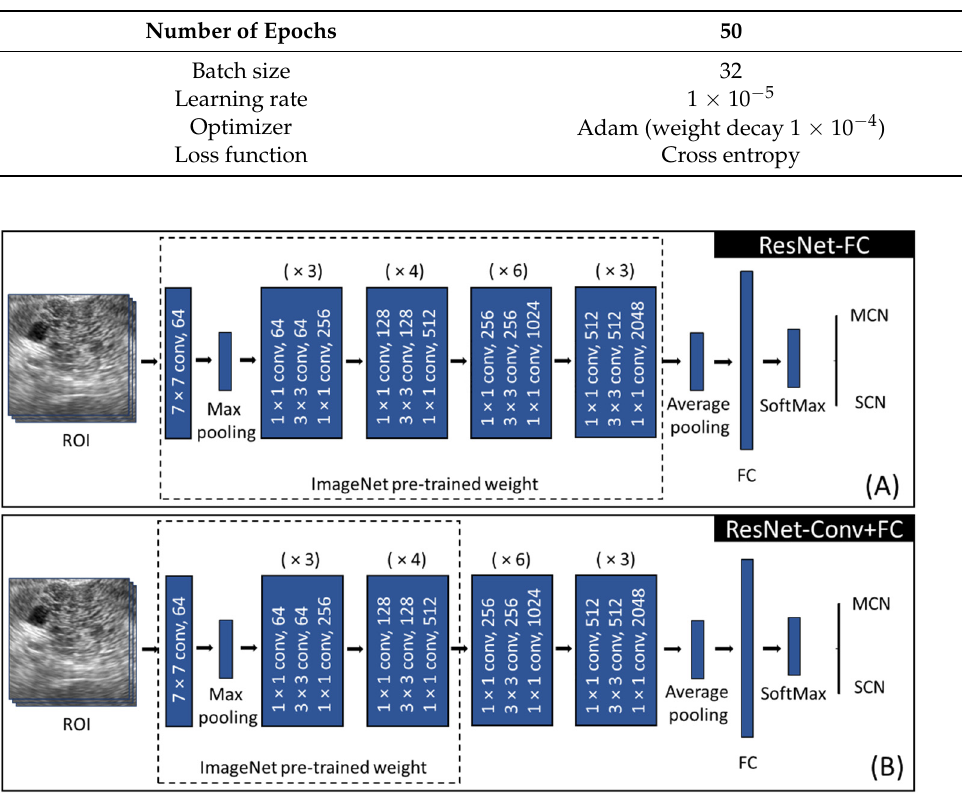
Figure 6. Training approach for ( A ) ResNet-FC, ( B ) ResNet-Conv+FC utilizing ResNet-50. (ROI: region of interest, FC: fully connected layer, MCN: mucinous cystic neoplasm, SCN: serous cystic neoplasm, ( × N ): N times block